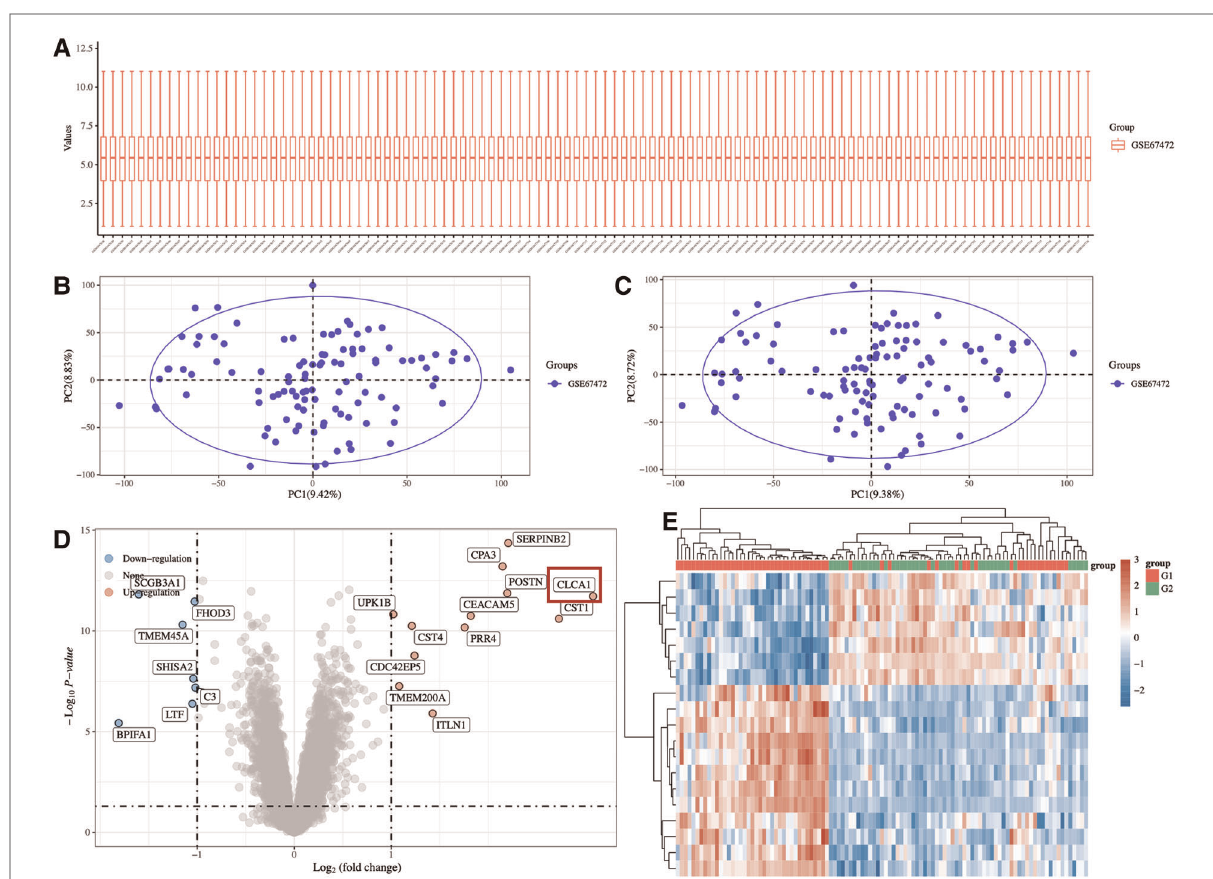
FIGURE 1 Pro fi le of mRNA in the airway epithelium of asthma patients and normal people. ( A ) Heatmap depicting differentially expressed mRNAs in the airway epithelial tissues of 65 asthma patients and 43 normal airway epithelial tissues. ( B ) Volcano plot depicting the fold change values and p -values of differentially expressed